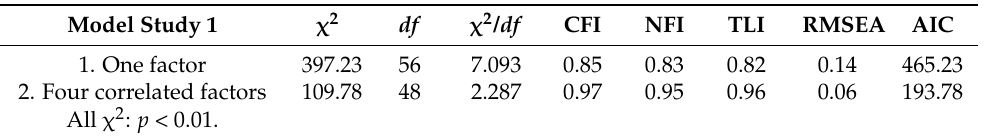
Table 4. Fit Indices from Confirmatory Factor Analysis of translated VAX scale. (Estimation method: Maximum